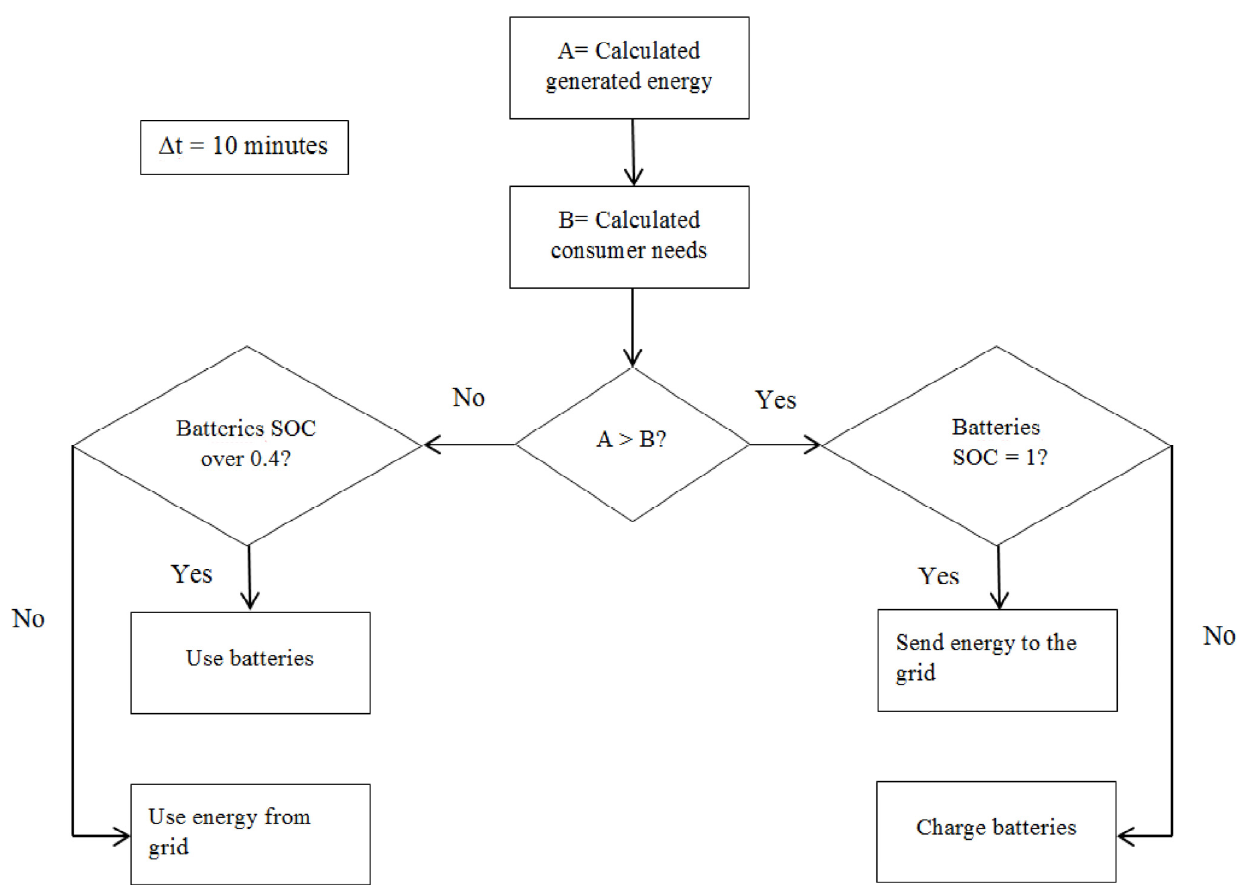
Figure 4. Energy balance algorithm